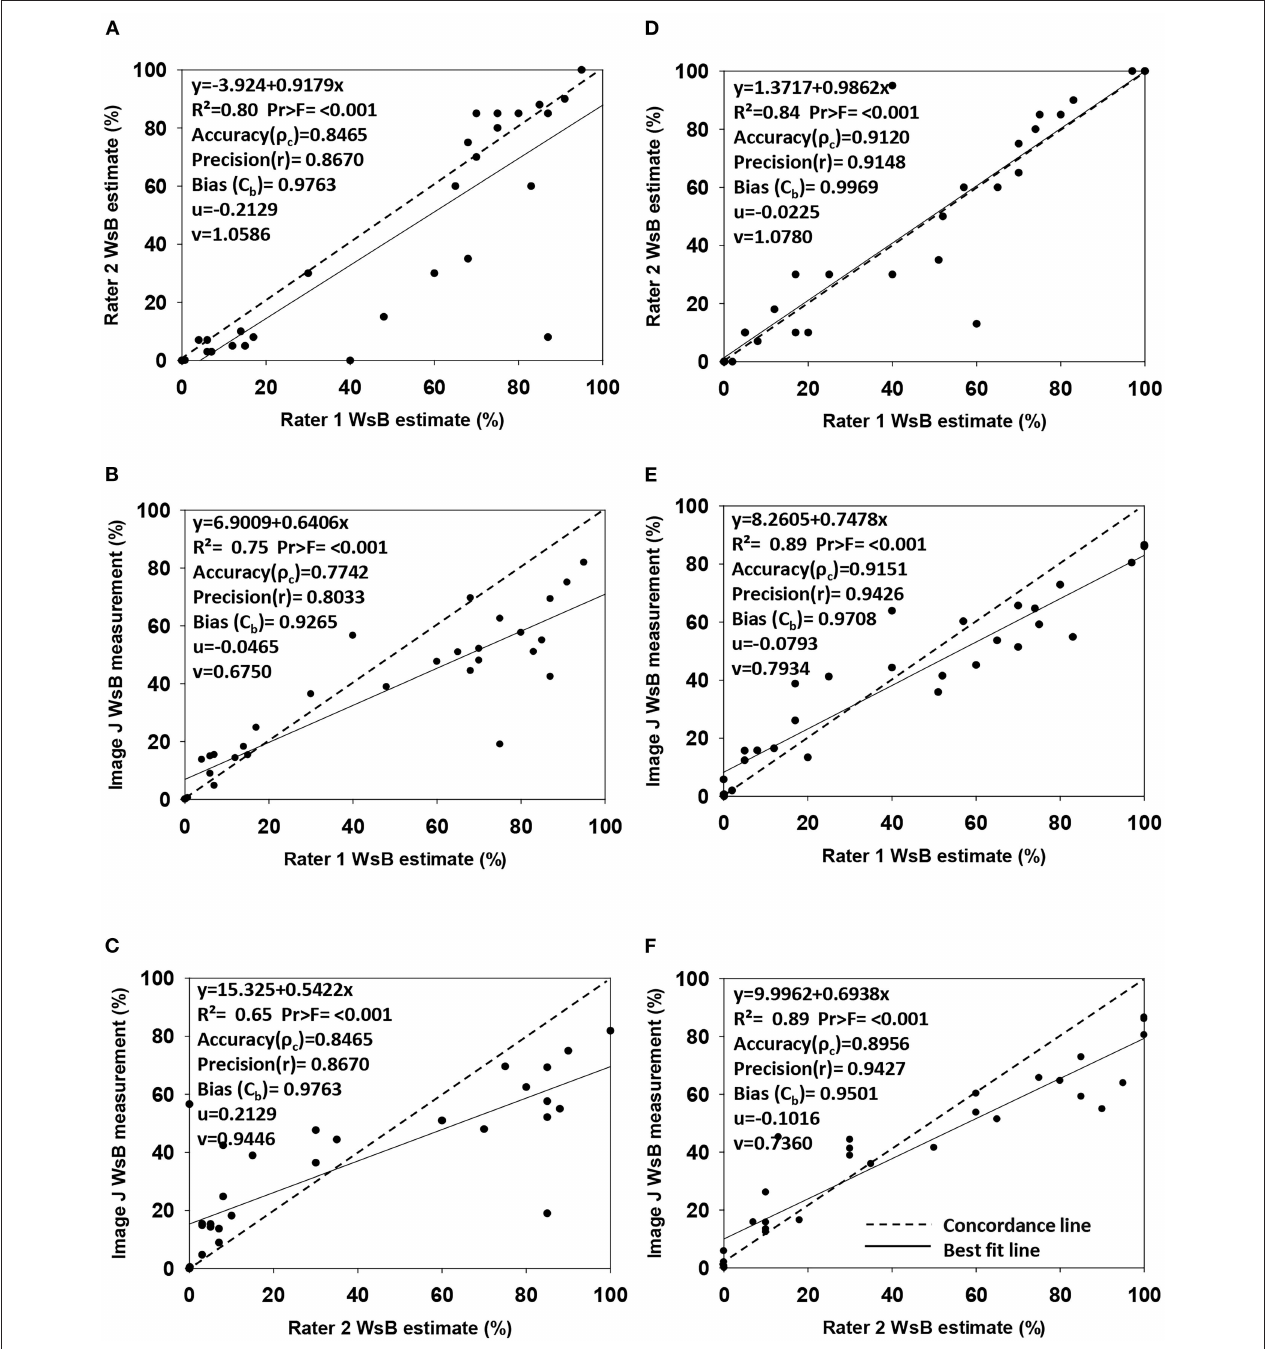
FIGURE 3 | Regression analysis of wheat spike blast DS estimations made by Rater 1 (responsible to estimate the severity of total image dataset) vs. Rater 2 (expert in wheat blast) and ImageJ DS measurements (image analysis software). Graphs show accuracy ( ρ c ), precision(r), bias (Cb), scale shift ( ν ), and location shift (u) for wheat spike blast continuous Dataset 1 (A–C) ( n = 31 images) and Dataset 2 (D–F) ( n = 29 images). (A) Disease estimation comparison from images Dataset 1 between Rater 1 and Rater 2. (B) Disease estimation and disease measurement comparison from images Dataset 1 between Rater 1 and ImageJ. (C) Disease estimation and disease measurement comparison from images Dataset 1 between Rater 2 and ImageJ. (D) Disease estimation comparison from images Dataset 2 between Rater 1 and Rater 2. (E) Disease estimation and disease measurement comparison from images Dataset 2 between Rater 1 and ImageJ. (F) Disease estimation and disease measurement comparison from images Dataset 2 between Rater 2 and ImageJ.